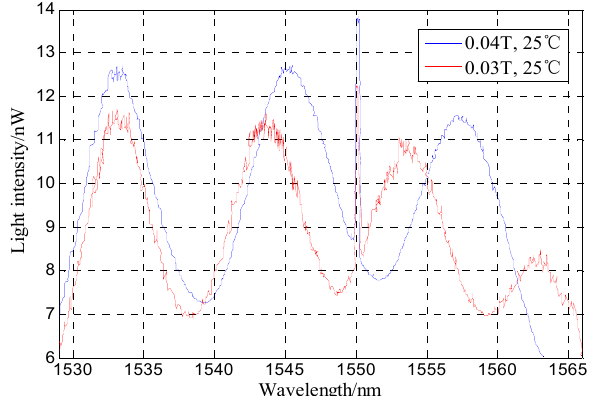
Figure 6. Spectrograms under a magnetic field range of 0~30 mT.